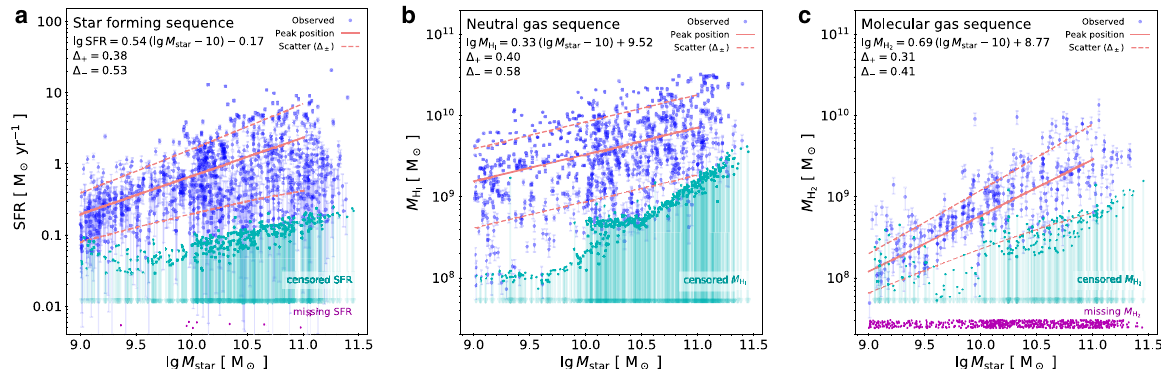
Fig. 1 Scaling relations of nearby galaxies. Slope, normalization, and scatter of the star-forming sequence ( a ), neutral gas sequence ( b ), and molecular gas sequence ( c ). Points show the representative sample based on the xGASS / xCOLD GASS data sets 13,14 . Speci fi cally, detected SFRs and gas masses are shown as blue circles with error bars indicating measurement uncertainties (one standard deviation). A large fraction of the observational data are either undetected/censored (cyan arrows) or missing (purple dots) necessitating careful modeling to avoid systematic biases. Peak position and scatter of each sequence, as determined by this study, are shown by solid and dashed lines. The peak position is de fi ned as the mode of the conditional probability density of lg SFR, lgM H , and lgM H given M star . The predicted scaling of the peak position with stellar mass as well as the upward ( Δ + ) and downward ( Δ − ) I 2 scatter of each sequence for M star = 10 10 M ⊙ galaxies are listed in the legend of each